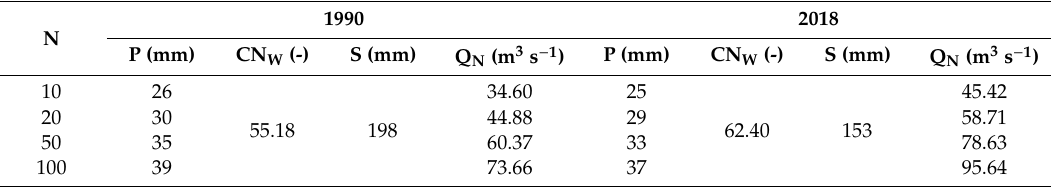
Figure 12. The actual design values of the short-term rainfall for the Liptovska Tepli č ka climatological station. The duration of the design short-term rainfall was selected according to the time of the concentration, which was calculated from the mean runoff velocity along the runoff path (determined according to Alena [53]). The time of concentration and runoff velocity is affected by the slope of the terrain and the land use and land cover along the runoff´s path. In the case of the Boca River basin, the land use along the path has changed significantly over time; hence, the time of concentration/duration for 1990 (80 min) is different than that for 2018 (69 min). In the case of the Ipoltica River, the duration of the design short-term rainfall was determined to be equal to 84 min for 1990 and 2018.